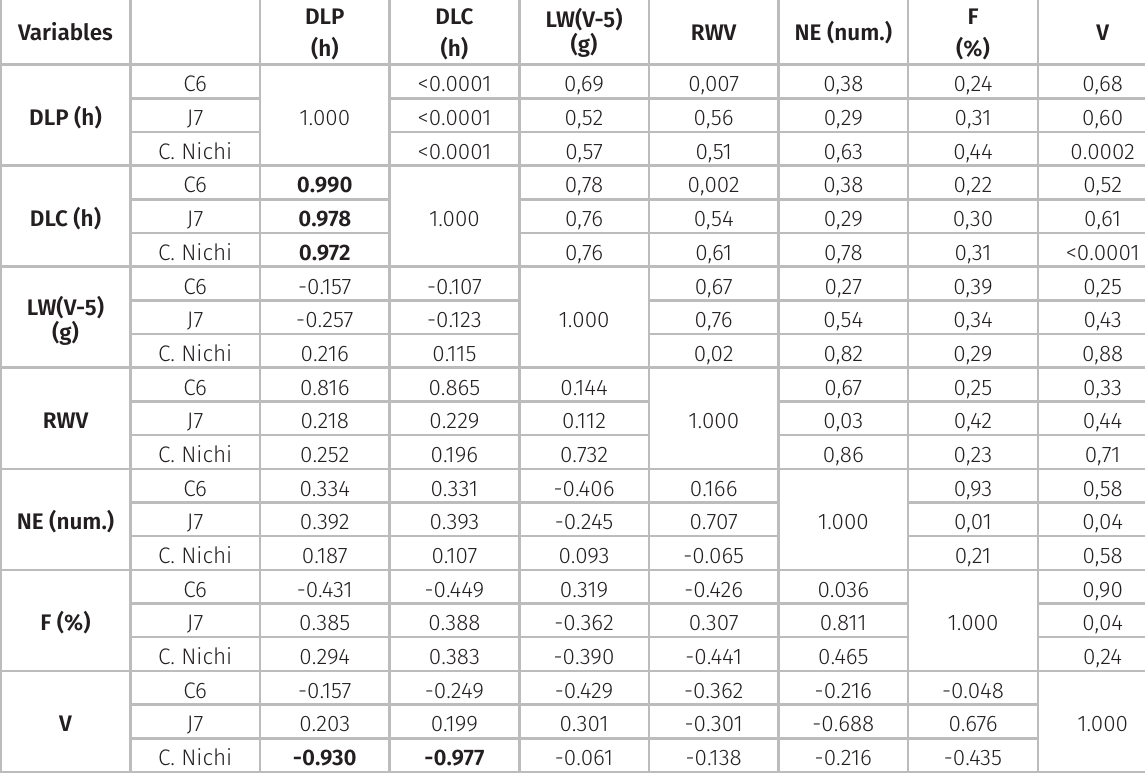
Table IV. Matrix of correlation between biological variables (estimated values and their significance are below and above the diagonal, respectively). Very high correlations are shown in bold. DLP: duration of the larval period, DLC: duration of the life cycle, LW(V-5): larval weight of the fifth day of the fifth instar, RWV: rate of weight gain of the fifth instar, NE: number of eggs, F: fertility, V: